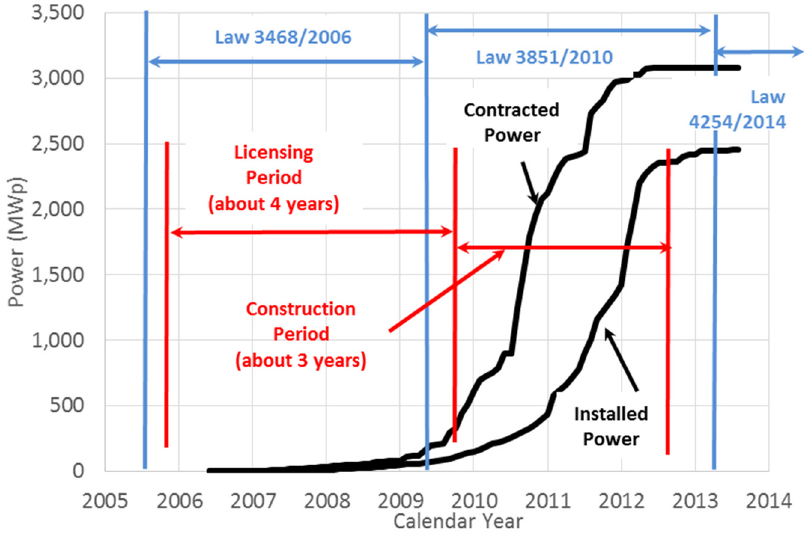
Figure 1. Photovoltaic Penetration in Greece. Data from Hellenic Electricity Market